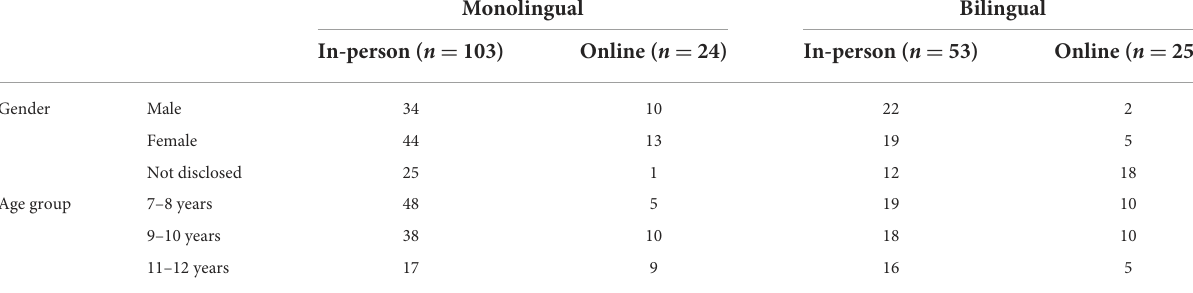
TABLE 1 Frequency of gender and age group by condition and language group.